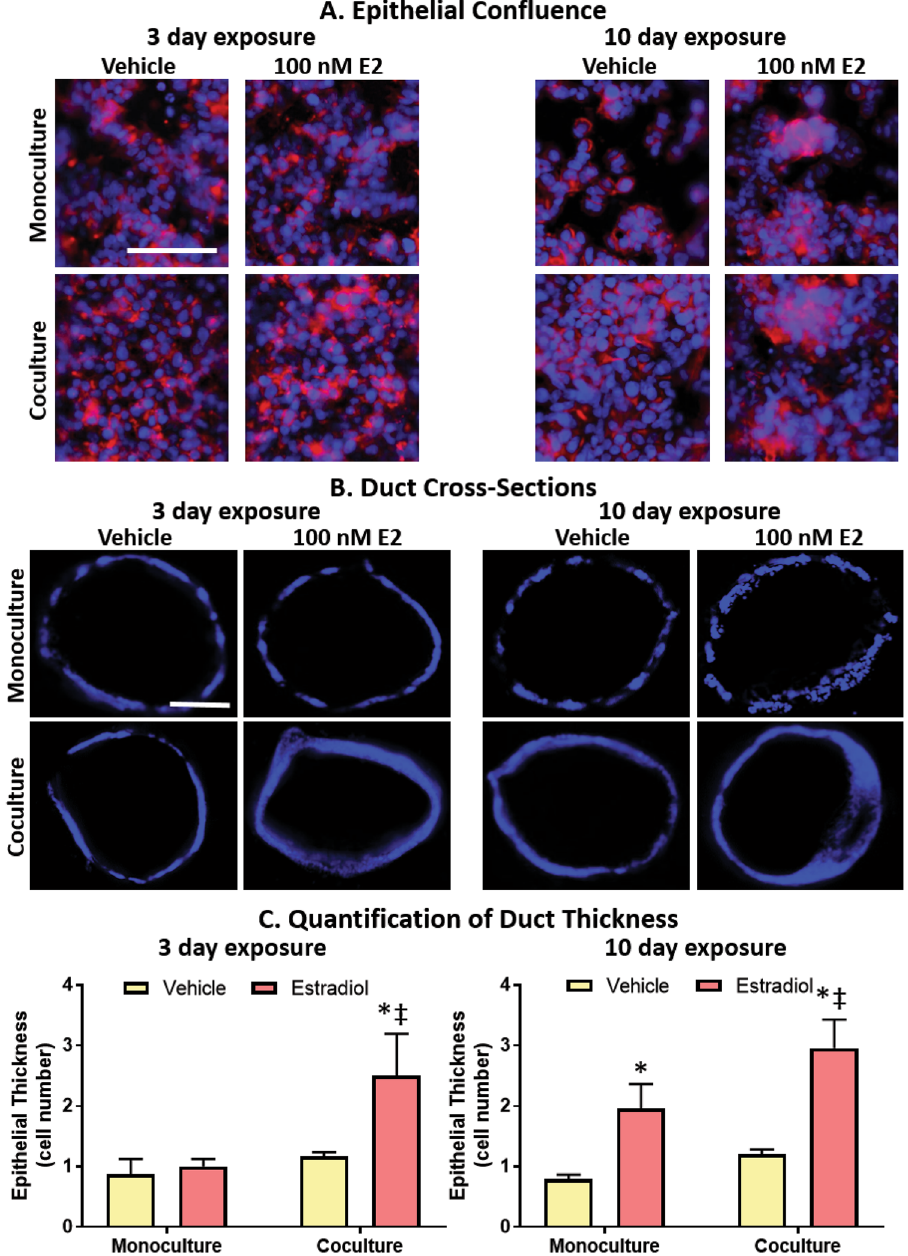
Figure 6. Fibroblasts prolong epithelial confluence and speed the onset as well as the severity of E2-induced hyperplasia. ( A ) Samples were stained for Hoescht (blue) and phalloidin (red) to visualize nuclei and F-actin, respectively. ( B ) To visualize hyperplasia, ducts were cross-sectioned and stained with Hoescht (blue). Scale bars represent 100 μ m. ( C ) Quantification of hyperplasia. Each condition represents the cross-sections of three ducts. A two-way ANOVA was run to evaluate interactions between conditions, followed by a Tukey’s multiple comparisons test to identify significant differences. * = vs. respective vehicle (p < 0.05) and ‡ = vs. respective monoculture (p < 0.05). Data is representative of three independent